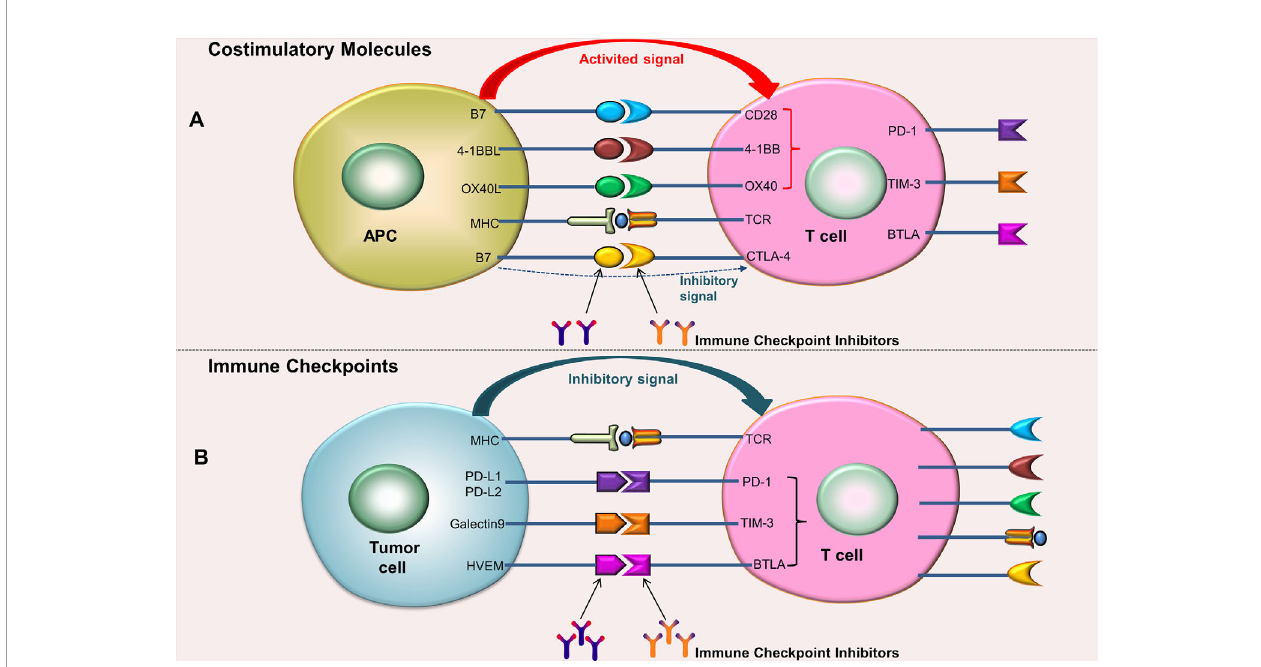
FIGURE 1 | Costimulatory molecules and Immune checkpoints. (A) After the costimulatory molecules on the surface of T cells bind to their ligands (located on the surface of the APC), activation signals can be generated, which can promote the activation and proliferation of T cells; the combination of CTLA-4 and B7 produces an inhibitory signals. (B) After the immune checkpoints on the surface of T cells bind to their ligands (located on the surface of tumor cells), inhibitory signals can be generated, which can inhibit T cell activation and proliferation. ICIs can block immune checkpoints or their ligands, thereby blocking the transmission of inhibitory signals to T